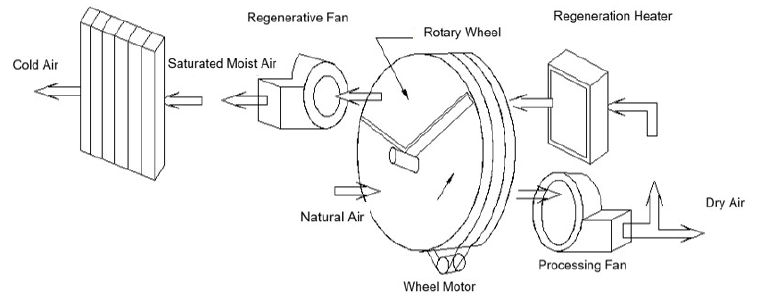
Figure 1. Schematic diagram of rotary air intake system.